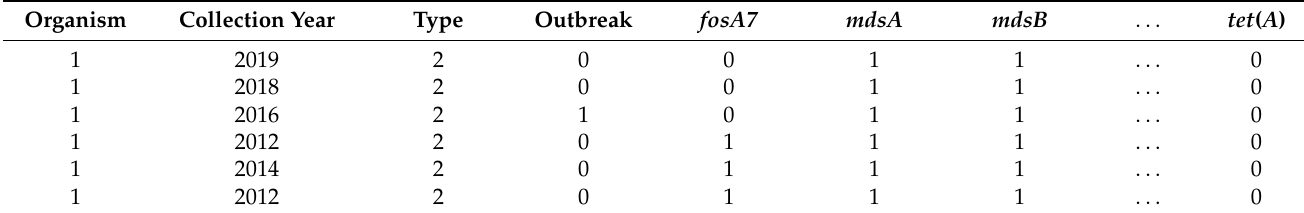
Table 1. A portion of the Excel data matrix for the outbreak Salmonella spp. dataset.